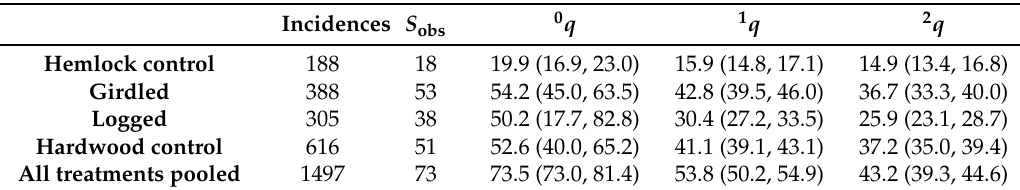
Table 1. Species richness (all years pooled) in the Harvard Forest Hemlock Removal Experiment. Values given are number of incidences (occurrences of species in both plots of each canopy manipulation treatment), number of species observed ( S obs ), and estimated Hill numbers (95% confidence intervals) for species richness ( 0 q ), Shannon diversity ( 1 q ), and Simpson’s diversity ( 2 q ).